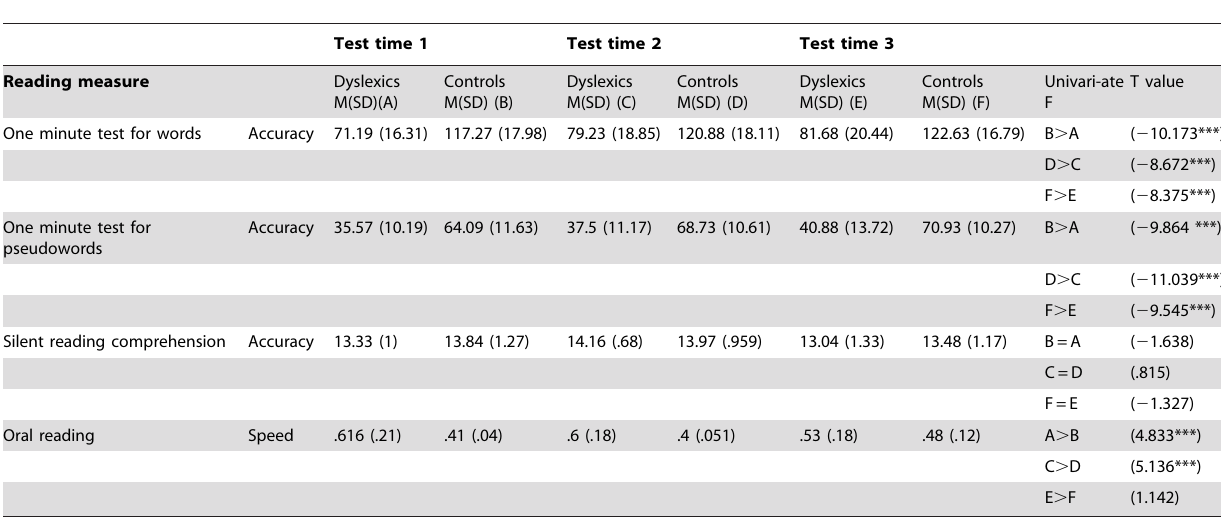
Table 2. A comparison of dyslexics and controls on reading measures for all tests.